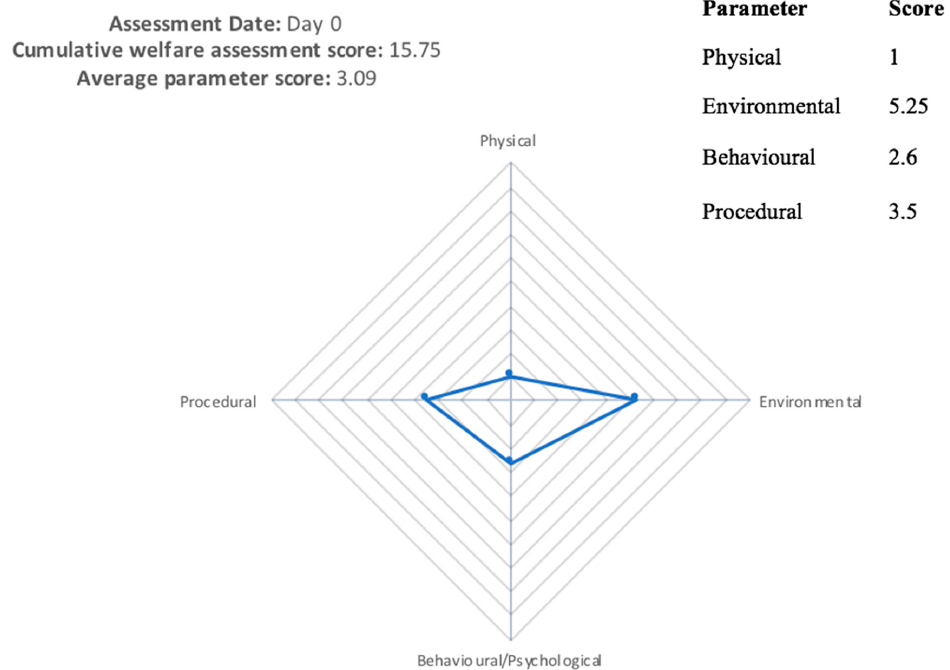
Figure 5. Cruciform grid showing welfare assessment for a bovine on day 0 undergoing blood sampling, showing a cumulative welfare assessment score (CWAS) of 15.75 when behavioural data were available. This CWAS score is calculated from the area of the grid.